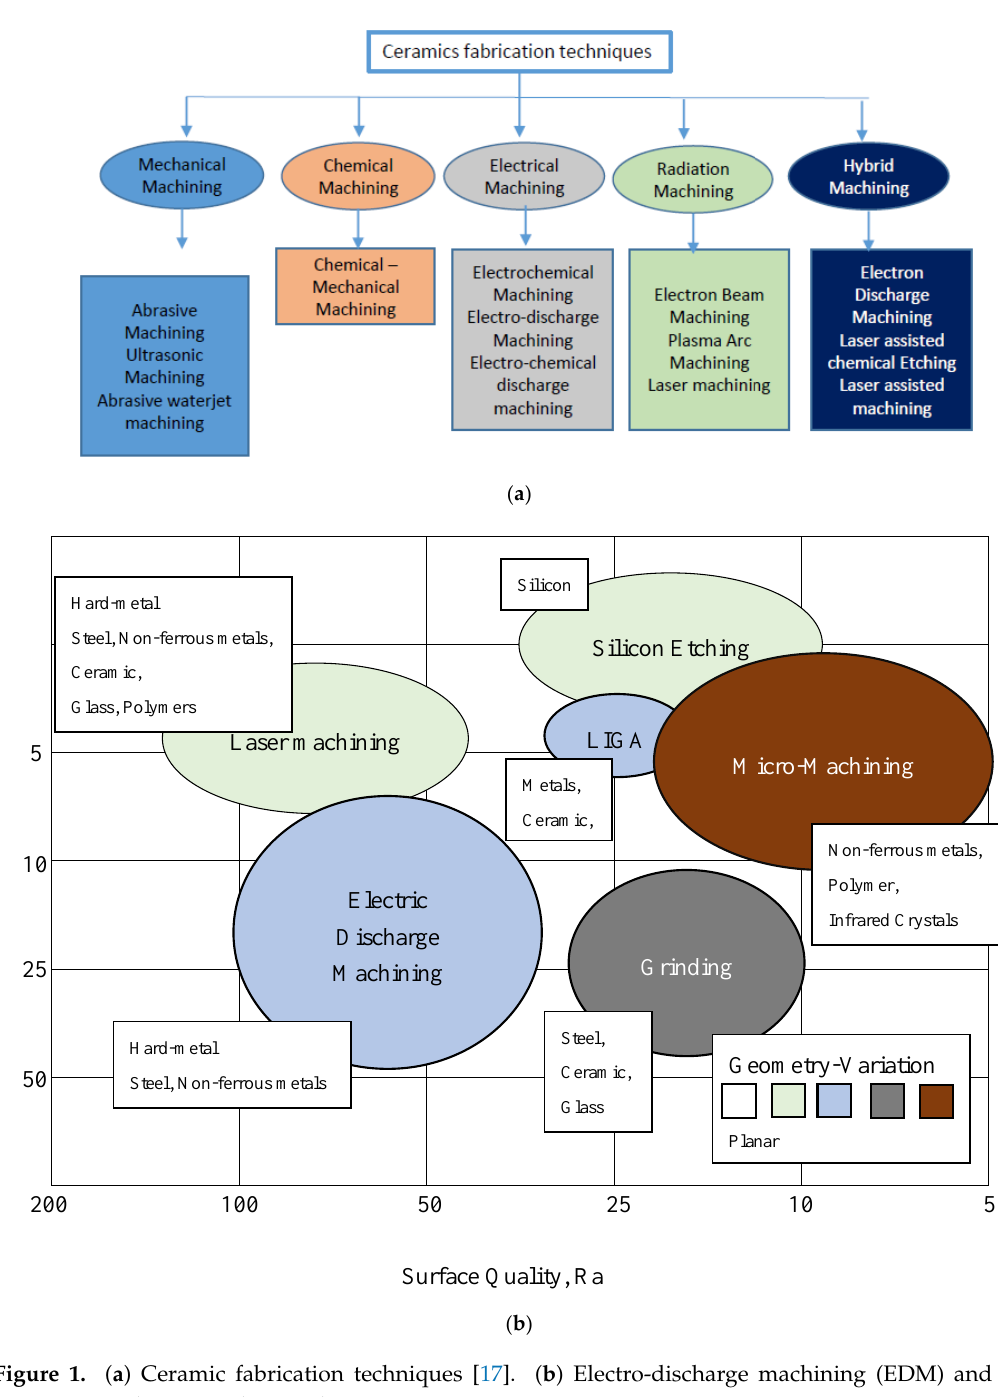
Figure 1. ( a ) Ceramic fabrication techniques [17]. ( b ) Electro-discharge machining (EDM) and micro-EDM relative to other machining processes.